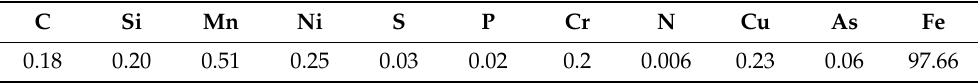
Table 2. Chemical composition of St3sp grade steel in